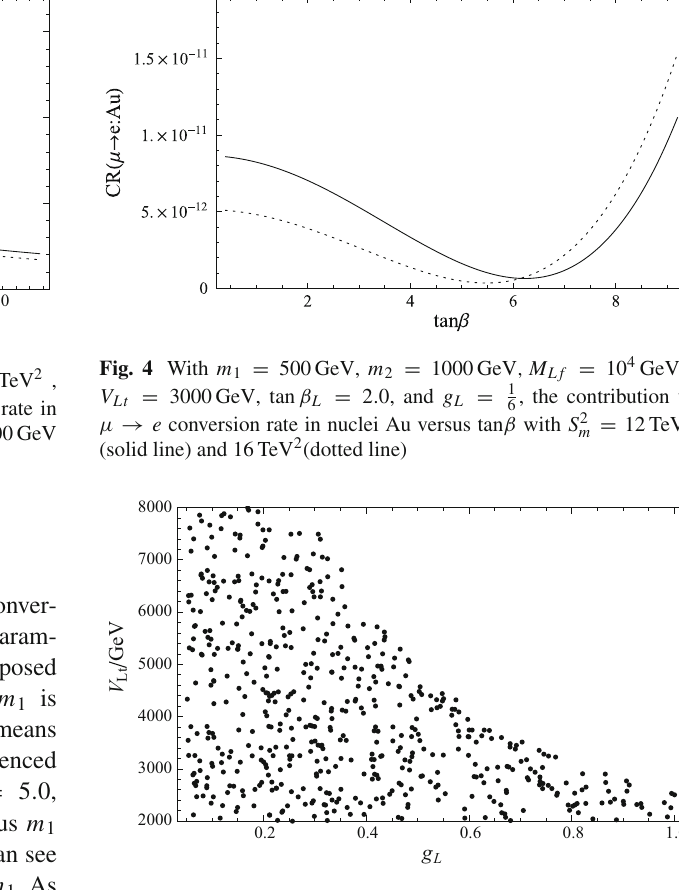
Fig. 5 For μ → e conversion rate in nuclei Au, the allowed parameter space in the plane of g L versus V Lt with m 1 = 1000GeV, m 2 = 1000GeV,tan β = 5 . 5, S 2 m = 16TeV 2 , M Lf = 10 4 GeV 2 andtan β L